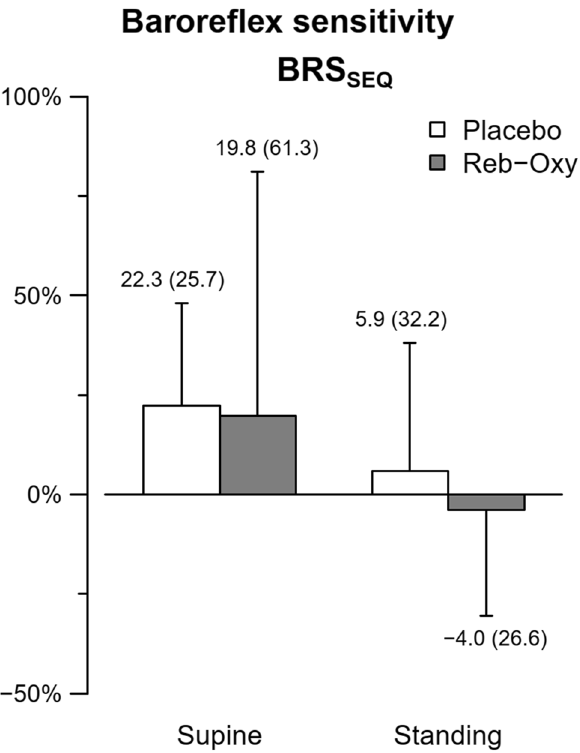
Figure 2. Baroreflex sensitivity by the sequence method. BRS SEQ percent change from baseline under placebo (white bar) and reb-oxy (grey bar) in supine and standing positions. Data are shown as medians (standard error). See Table 4 for the original values.